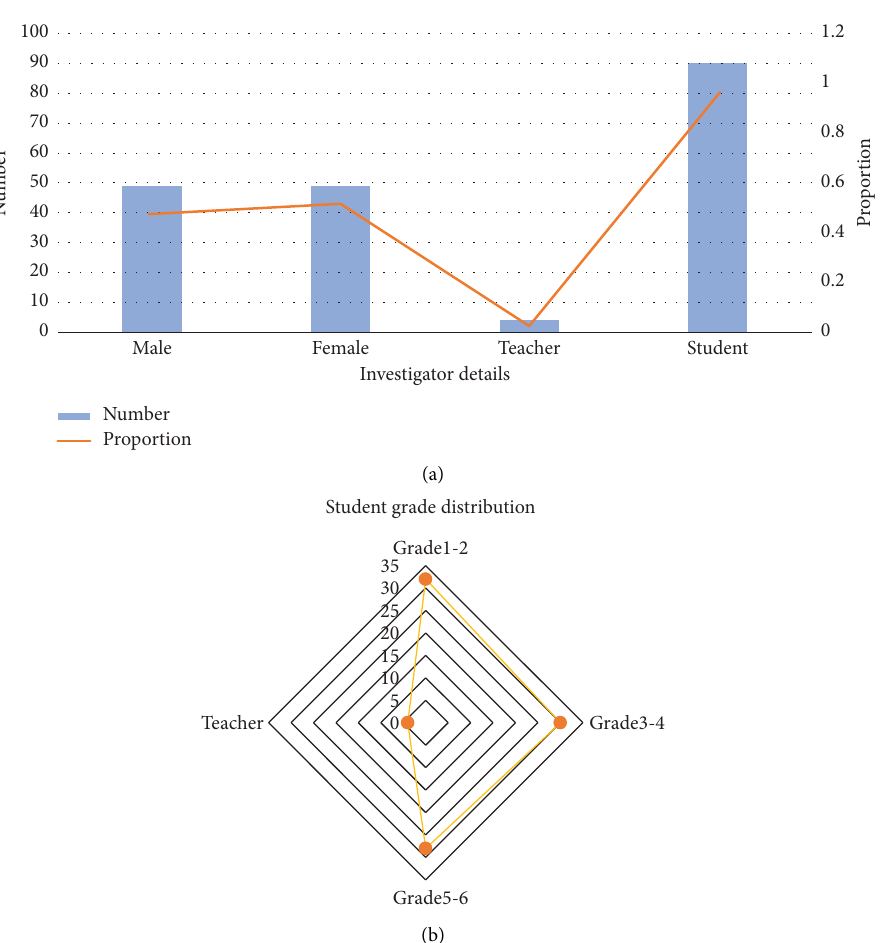
Figure 10: Te details of the respondents: (a) the identity of the respondents and (b) the age distribution of the respondents.